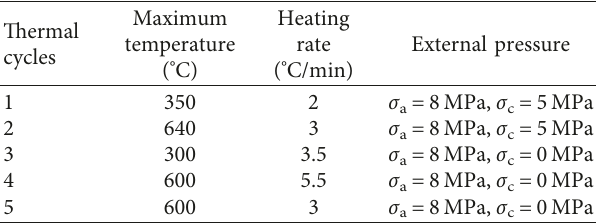
t was for about ▵